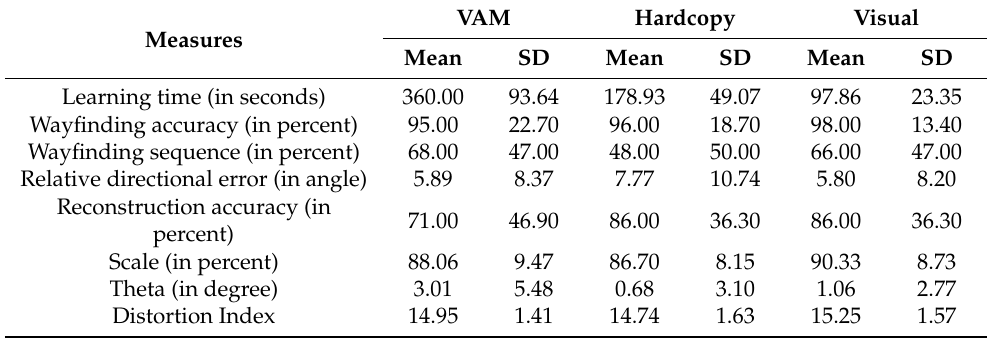
Table 5. Mean and standard deviation for tested measures as a function of learning-mode conditions.